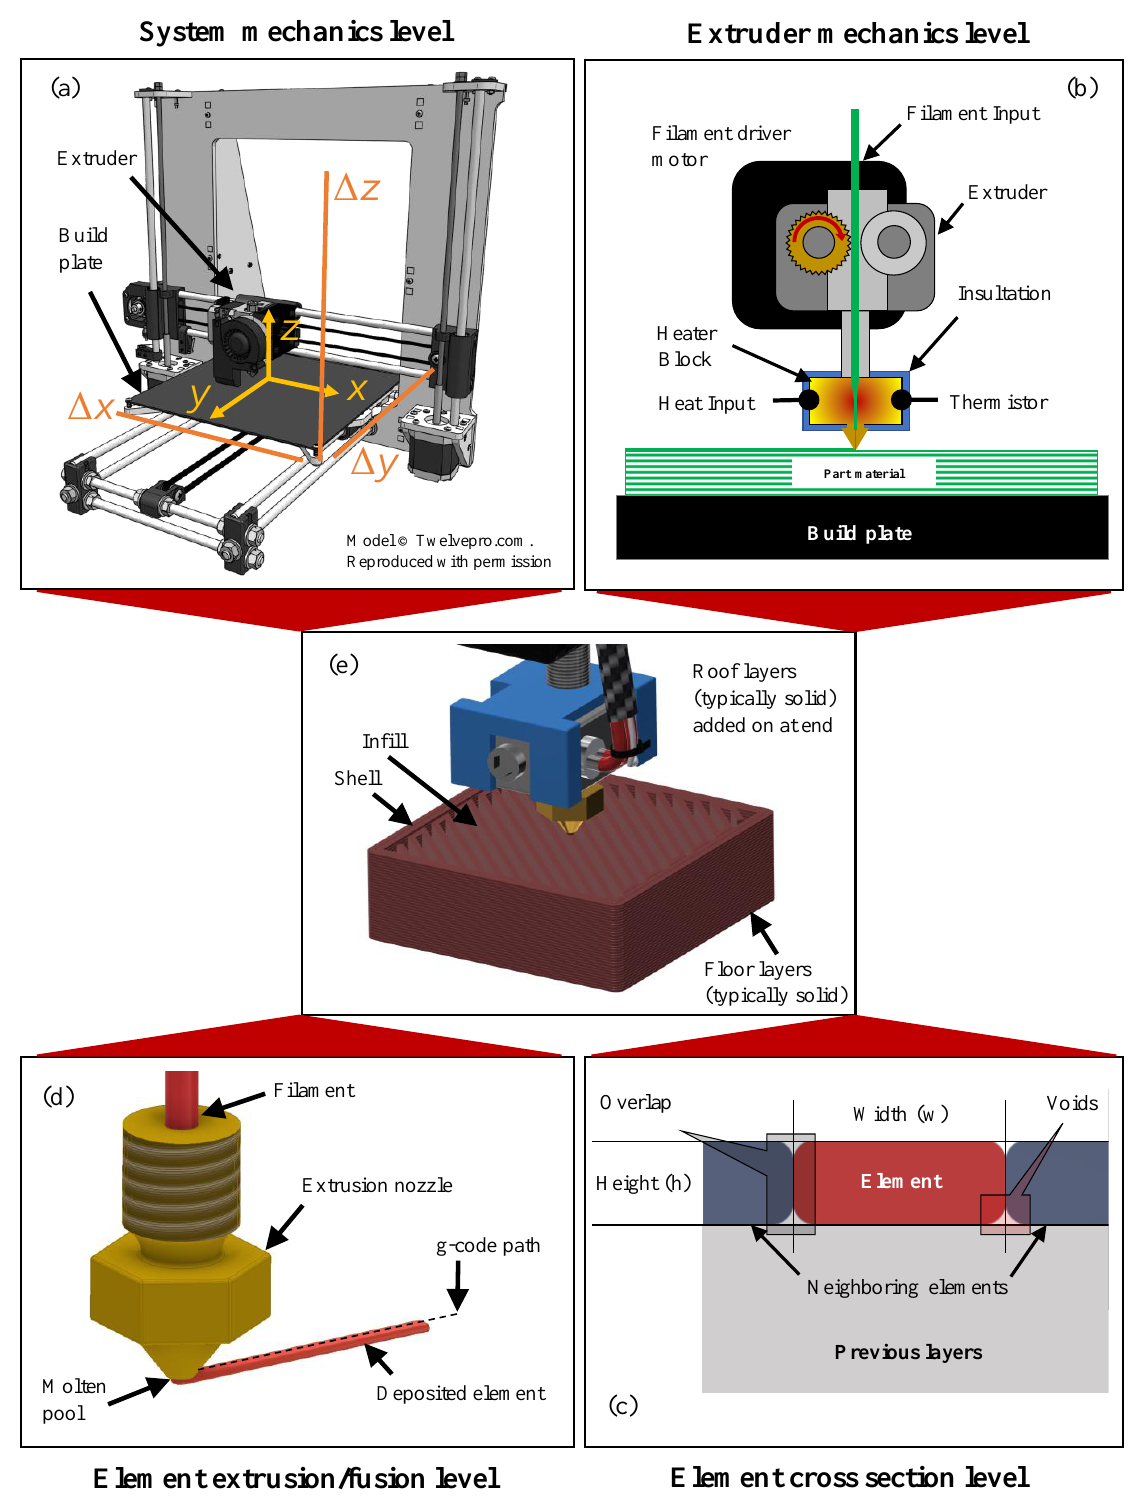
Figure 5. Levels of analysis for FDM. ( a ) System level, ( b ) extruder level, ( c ) element geometry level, and ( d ) element deposition/fusion level. Panel ( e ) shows the full